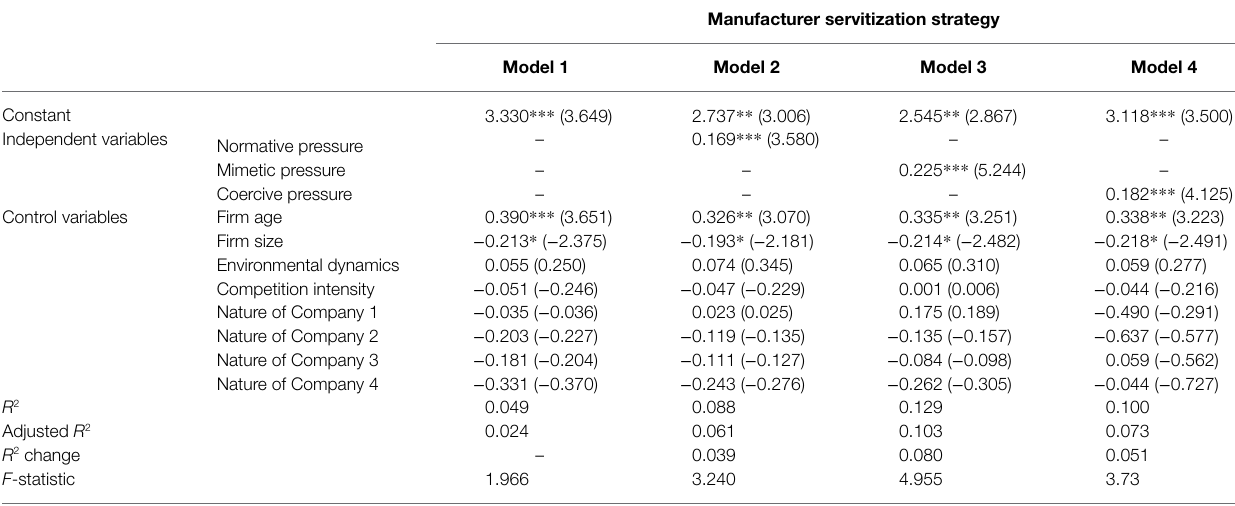
TABLE 5 | Regression analysis of institutional pressure on servitization strategy of manufacturers.